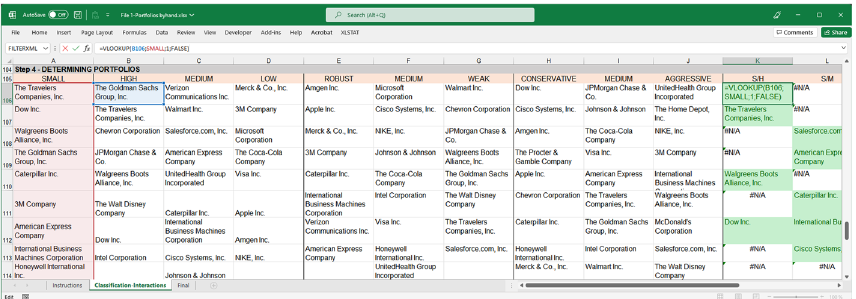
Fig. 3 The VLOOKUP function for interaction determination. Source : Created by